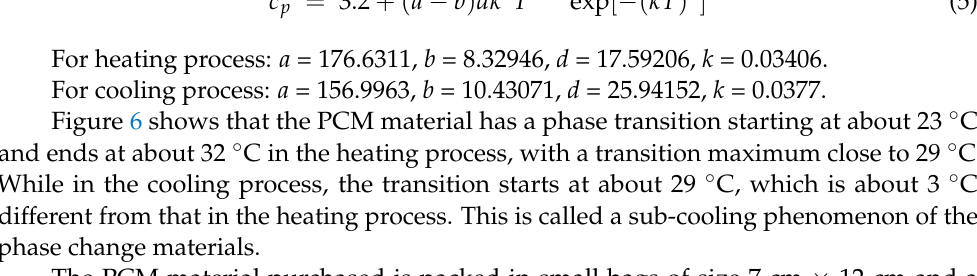
Figure 6. ( a ) Enthalpy data received from the PCM provider Climator Sweden AB; ( b ) Specific heat ( c p /(kJ/kgK)) of the PCM (Climsel 28) used in this study as a Weibull 2 function of temperature.